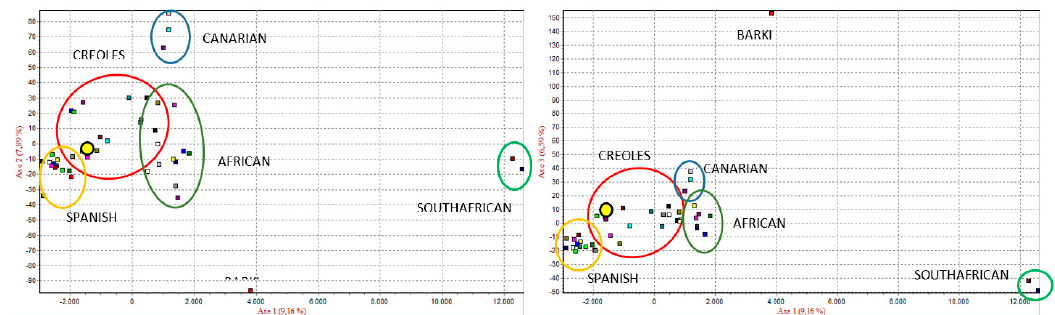
Figure 3. Correspondence Factor Analysis of 43 goat populations.